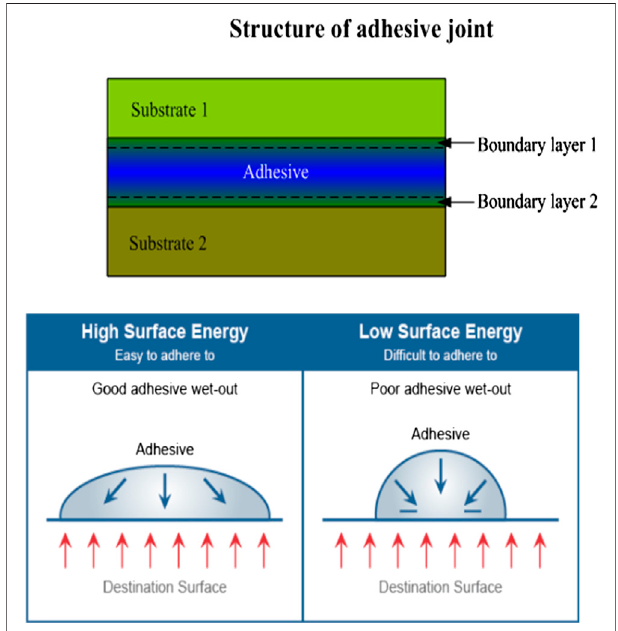
FIGURE 3 | Structure of adhesive joint and effect of surface